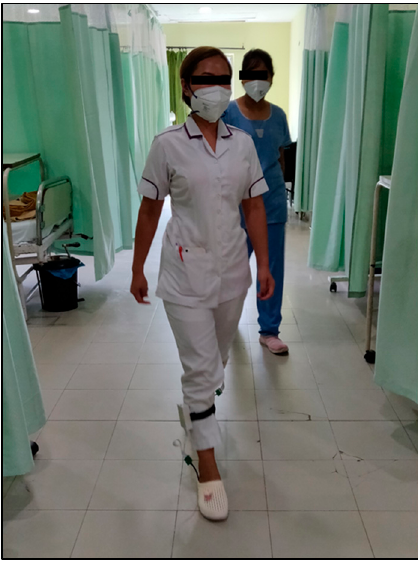
Figure 4. Subject walking with the smart